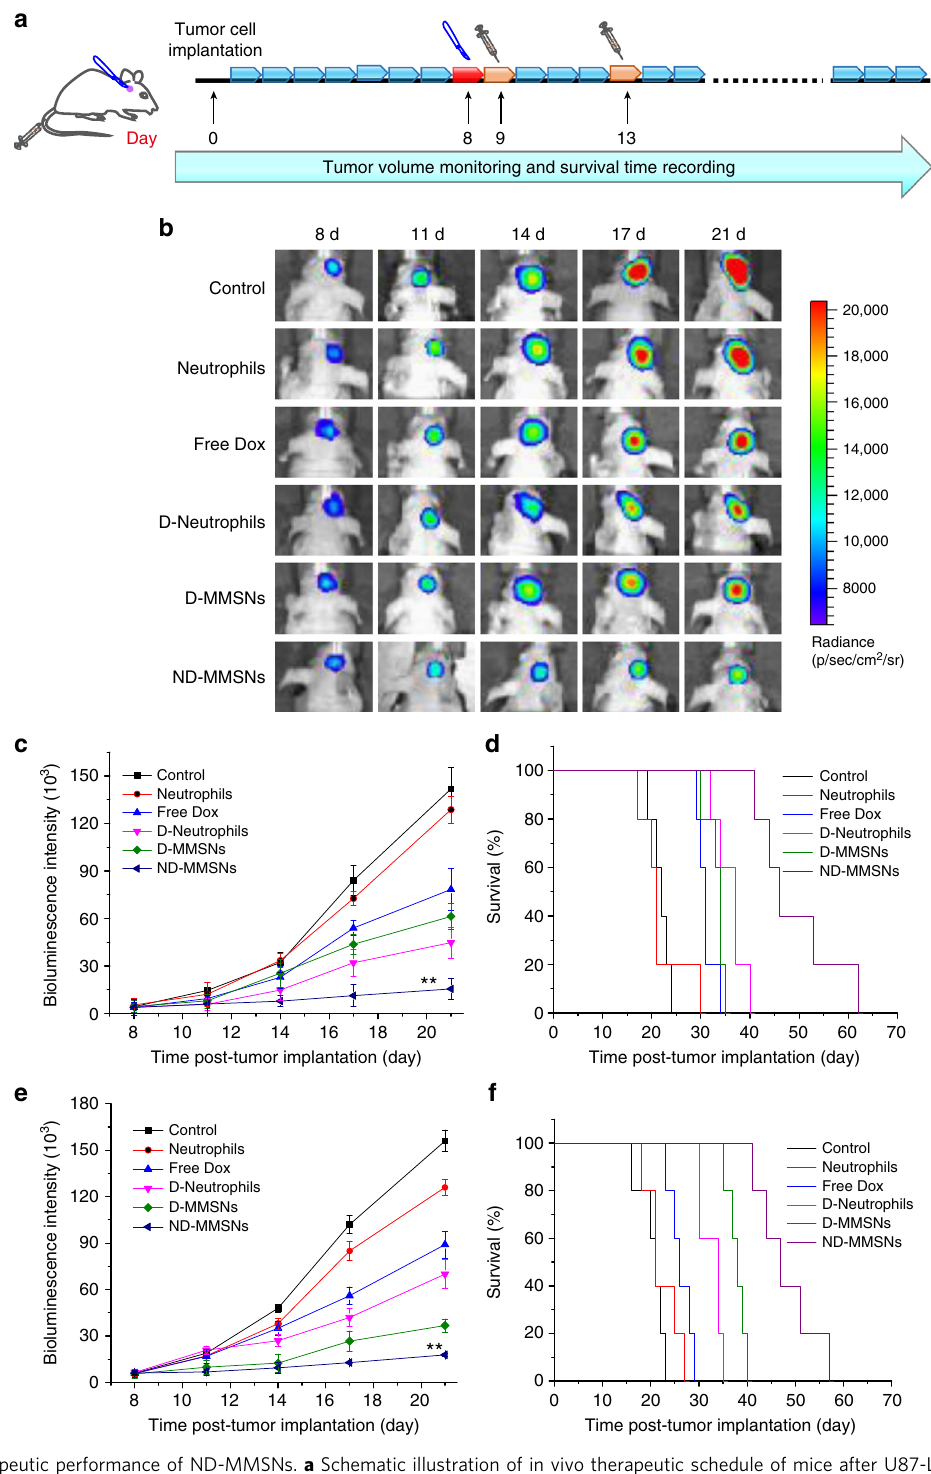
Fig. 6 In vivo therapeutic performance of ND-MMSNs. a Schematic illustration of in vivo therapeutic schedule of mice after U87-Luc glioma cells implantation, primary glioma resection, and treatment of ND-MMSNs delivery system. b In vivo bioluminescent images, c quanti fi ed signal intensity and d survival curves of U87 glioma-bearing mice from each group after various treatment indicated. Statistical signi fi cance is assessed by Student ’ s two-sided t test compared to the control group. ** P < 0.01. e Quanti fi ed signal intensity and f survival curves of C6 glioma-bearing mice from each group after various treatment indicated. Statistical signi fi cance is assessed by Student ’ s two-sided t test compared to the control group. ** P < 0.01. Mean values and error bars are de fi ned as mean and s.d., respectively ( n =